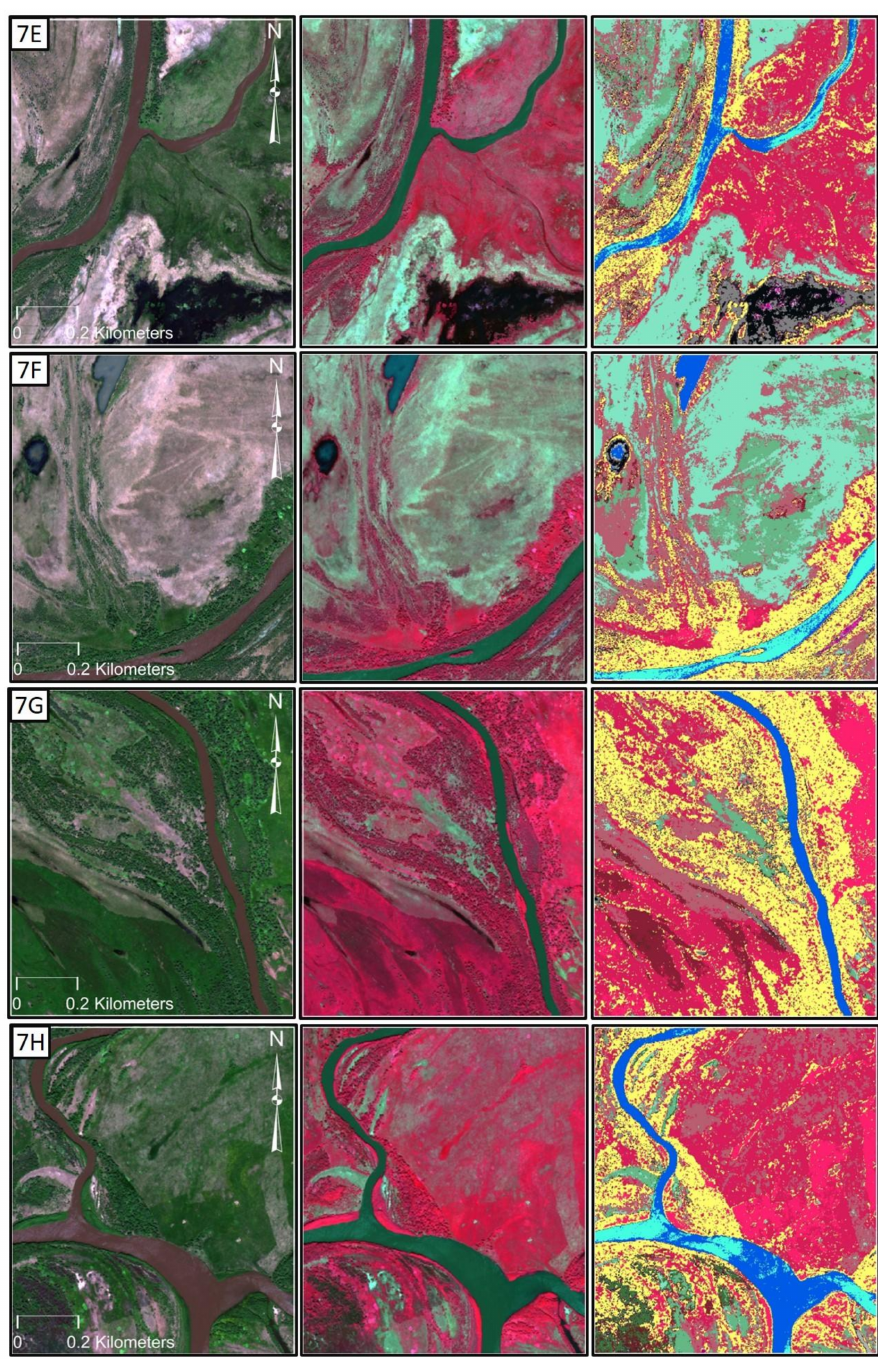
Figure 7. ( A–H ) . The vegetation of the Selenga River Delta follows a north-to-south and wetter-to-drier gradient, as evidenced by the abundance of different wetland classes within the white rectangles in Figure 6. The images are combined WV2 bands 532 ( left ), bands 753 ( middle ), and the wetland classification thematic map ( right ) using the legend in Figure